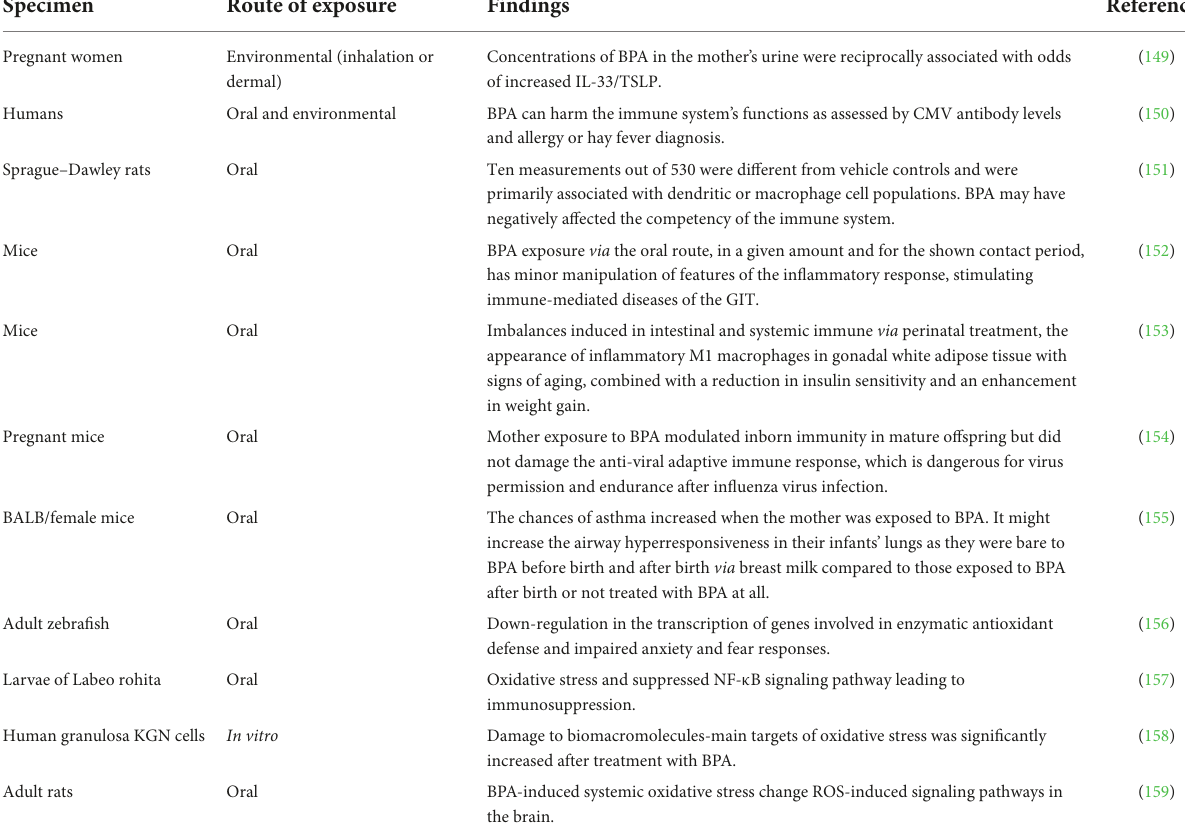
TABLE 5 Effect of BPA on the immune